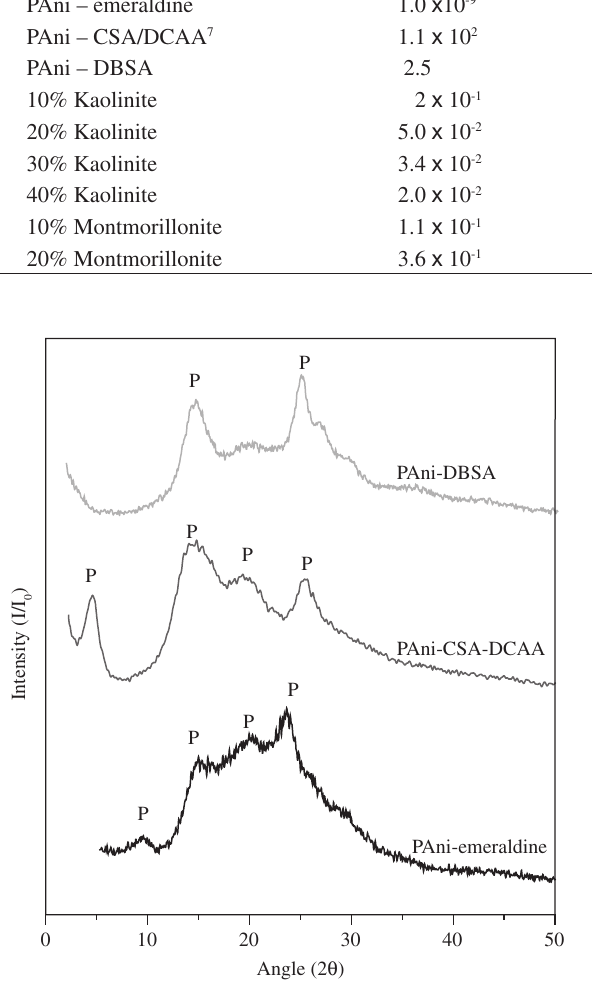
Table 1. Electrical conductivity values of the compositions under study. Composition